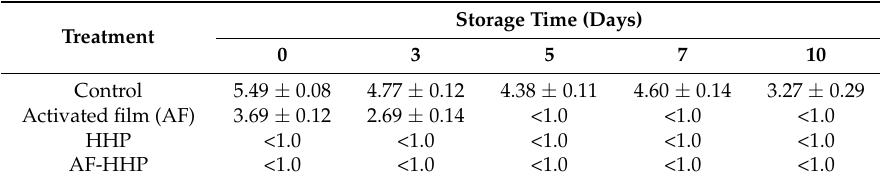
Table 2. Viable cell counts for Listeria in fruit puree challenged with the bacterium and stored under refrigeration. Fruit puree was packed in polyethylene-polyamide bags without any treatment (controls), or in bags activated with 0.5% thymol plus 80 mg/mL enterocin AS-48. When indicated, packed puree was treated by HHP (300 MPa, 5